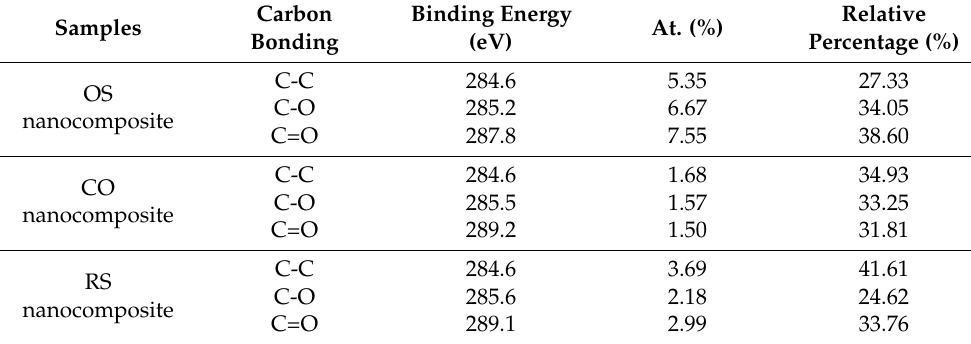
Table 2. The fitting results of C1s XPS spectrum of OS, CO, and RS nanocomposites.